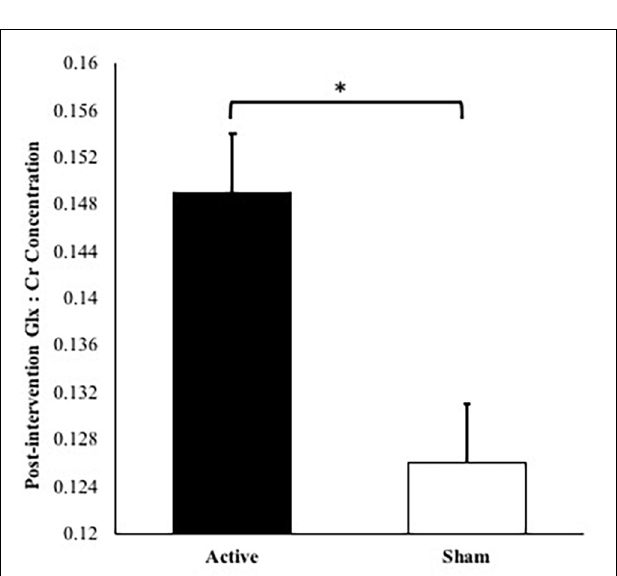
p = 0.052. The covariates, MoCA scores and baseline Glx:Cr